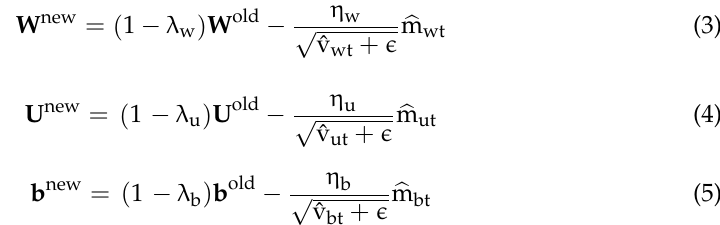
Figure 7. Flow chart of the training process .